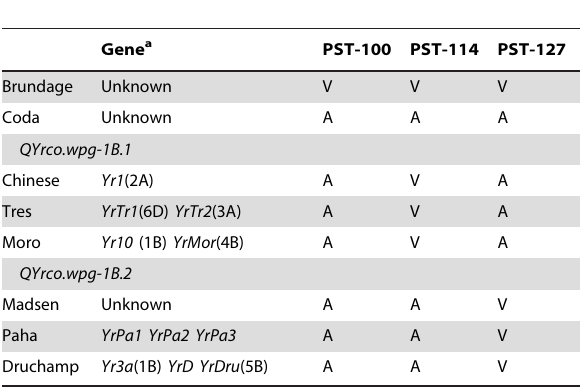
Table 3. Observed and predicted virulence and avirulence formula of three races of stripe rust tests against the Brundage by Coda recombinant inbreed line population for seedling